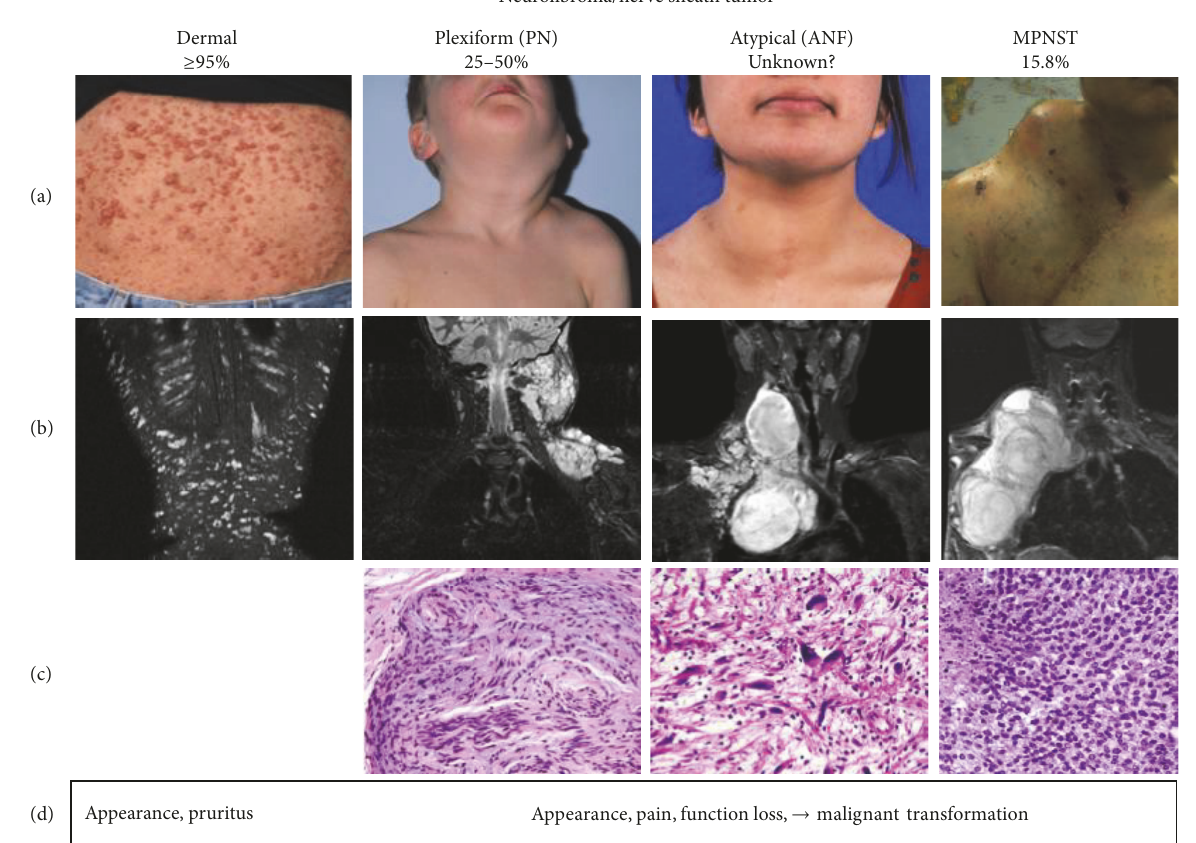
Figure 1: Pathogenesis of peripheral nerve sheath tumors in NF1. Percentages below each tumor type is the range of lifetime prevalence in individuals with NF1. Representative clinical photograph (a), MRI imaging (b), histology (c), clinical symptomology (d), and genetic features (e) of each tumor type are given. Histologically, plexiform neurofibroma shows mixture of areas of hypercellularity in the absence of other atypical features. Atypical neurofibroma shows atypical nuclei and higher cellularity. In contrast, MPNST are highly cellular with high mitotic activity and areas of